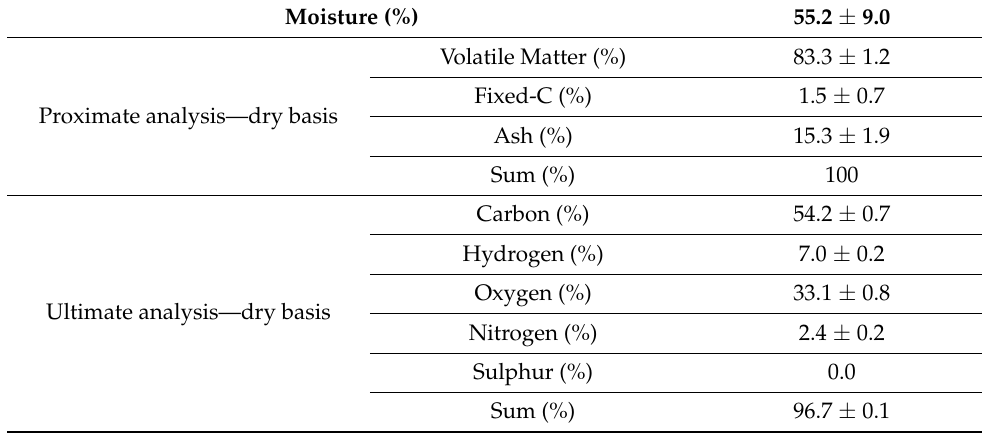
Table 1. The proximate analysis and ultimate analysis of spent coffee grounds